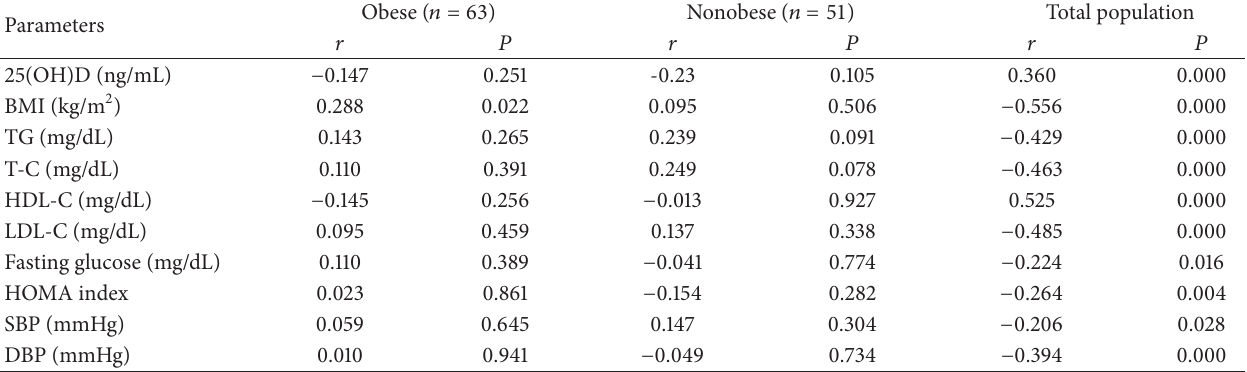
Table 4: Correlations between adiponectin levels and other parameters in the total study, obese group, and nonobese group.